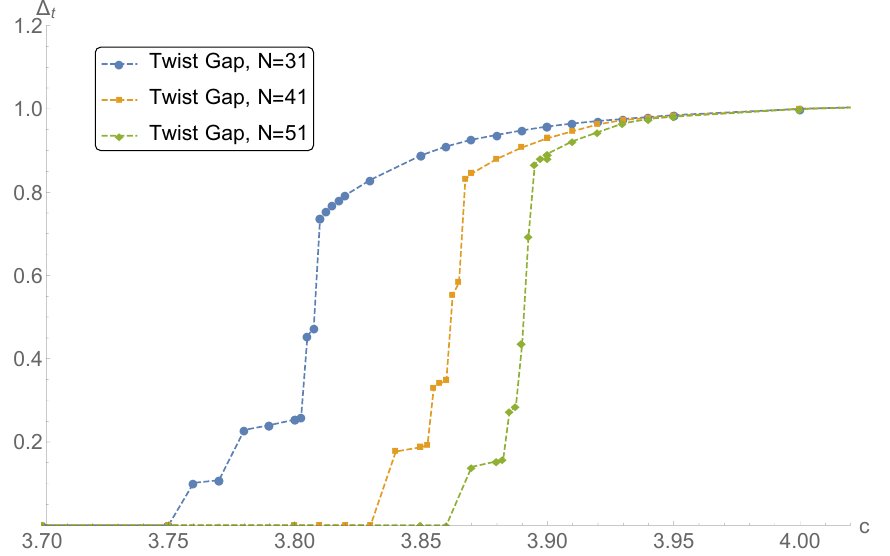
Figure 17. Numerical upper bounds on twist gap with W ( F 4 ) = W (2 ; 6 ; 8 ; 12) algebra in the range of 3 : 7 (cid:20) c (cid:20) 4 : 0. The sharp cli(cid:11) is pushed towards c = 4 as the number of derivatives gets